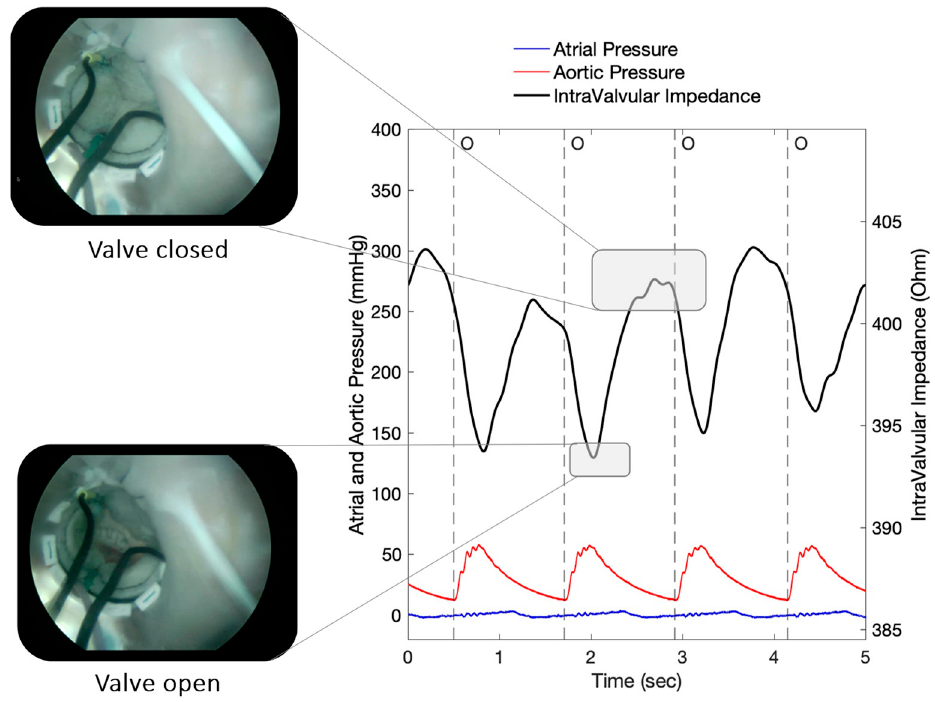
Figure 5. IVI signal profile reflecting the opening and closing dynamics of the valve. O = start of valve opening identified with the low peak of the aortic pressure.